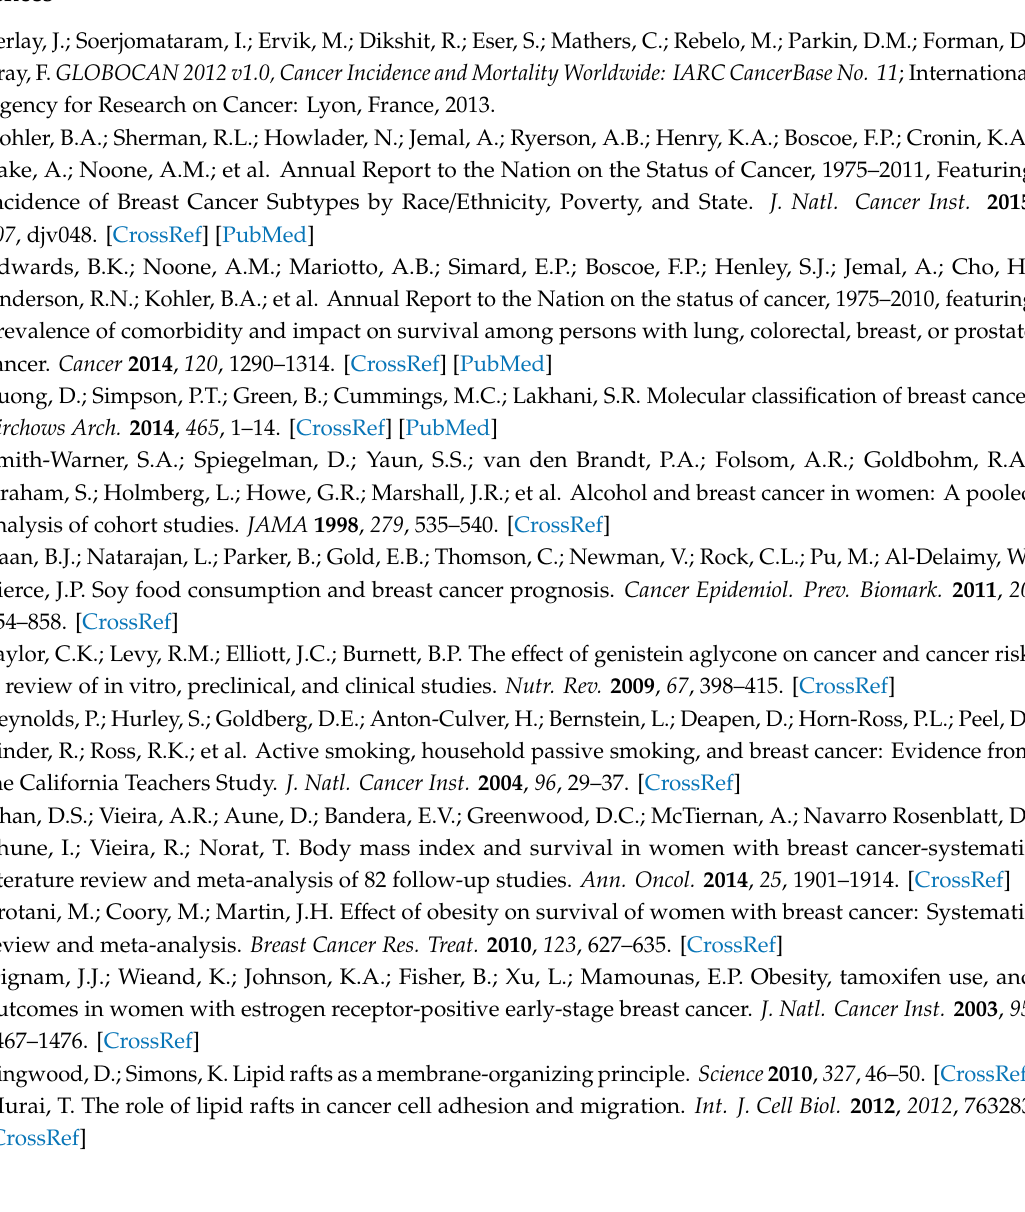
Table S1: Characteristics by quartile of TC at baseline in breast cancer patients who underwent a surgery; Table S2: Characteristics by quartile of LDL at baseline in breast cancer patients who underwent a surgery; Table S3: Characteristics by quartile of HDL at baseline in breast cancer patients who underwent a surgery; Table S4: Characteristics by quartile of TG at baseline in breast cancer patients who underwent a